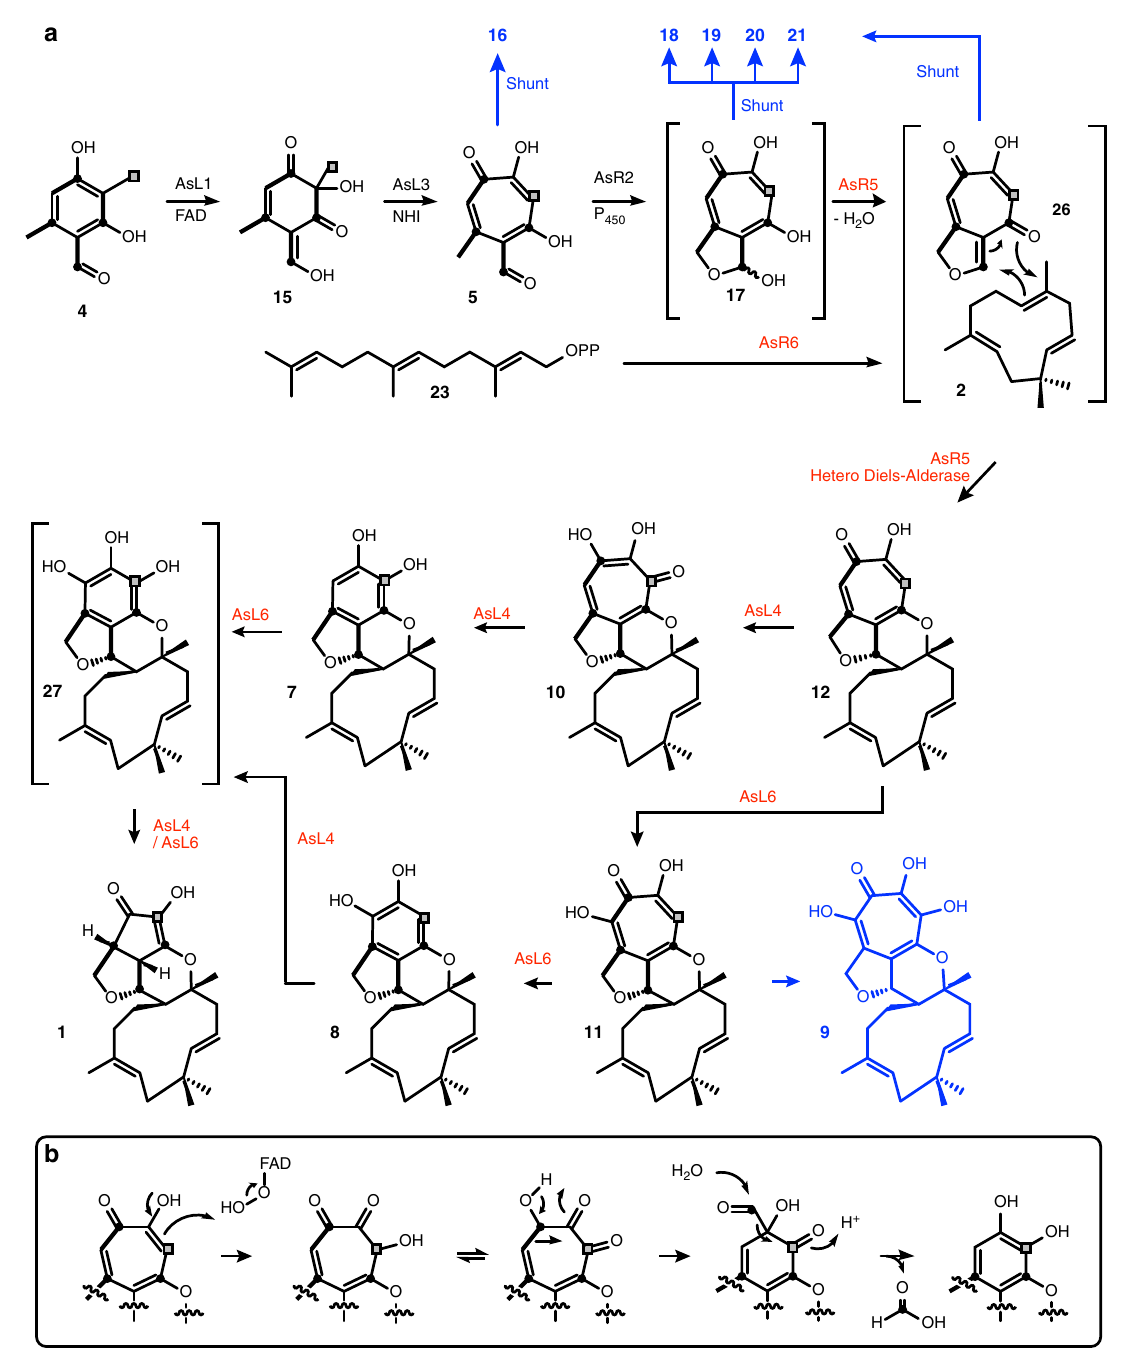
Fig. 7 Overall pathway. a Proposed pathway to 1 and routes to shunt metabolites (blue). Compounds in brackets are not directly observed. Red steps are previously unknown. b Proposed mechanism for oxidative-ring contraction 3 . Labelling pattern (bold bond, intact acetate; grey square from S -adenosyl methionine [SAM]) as observed by Simpson and coworkers